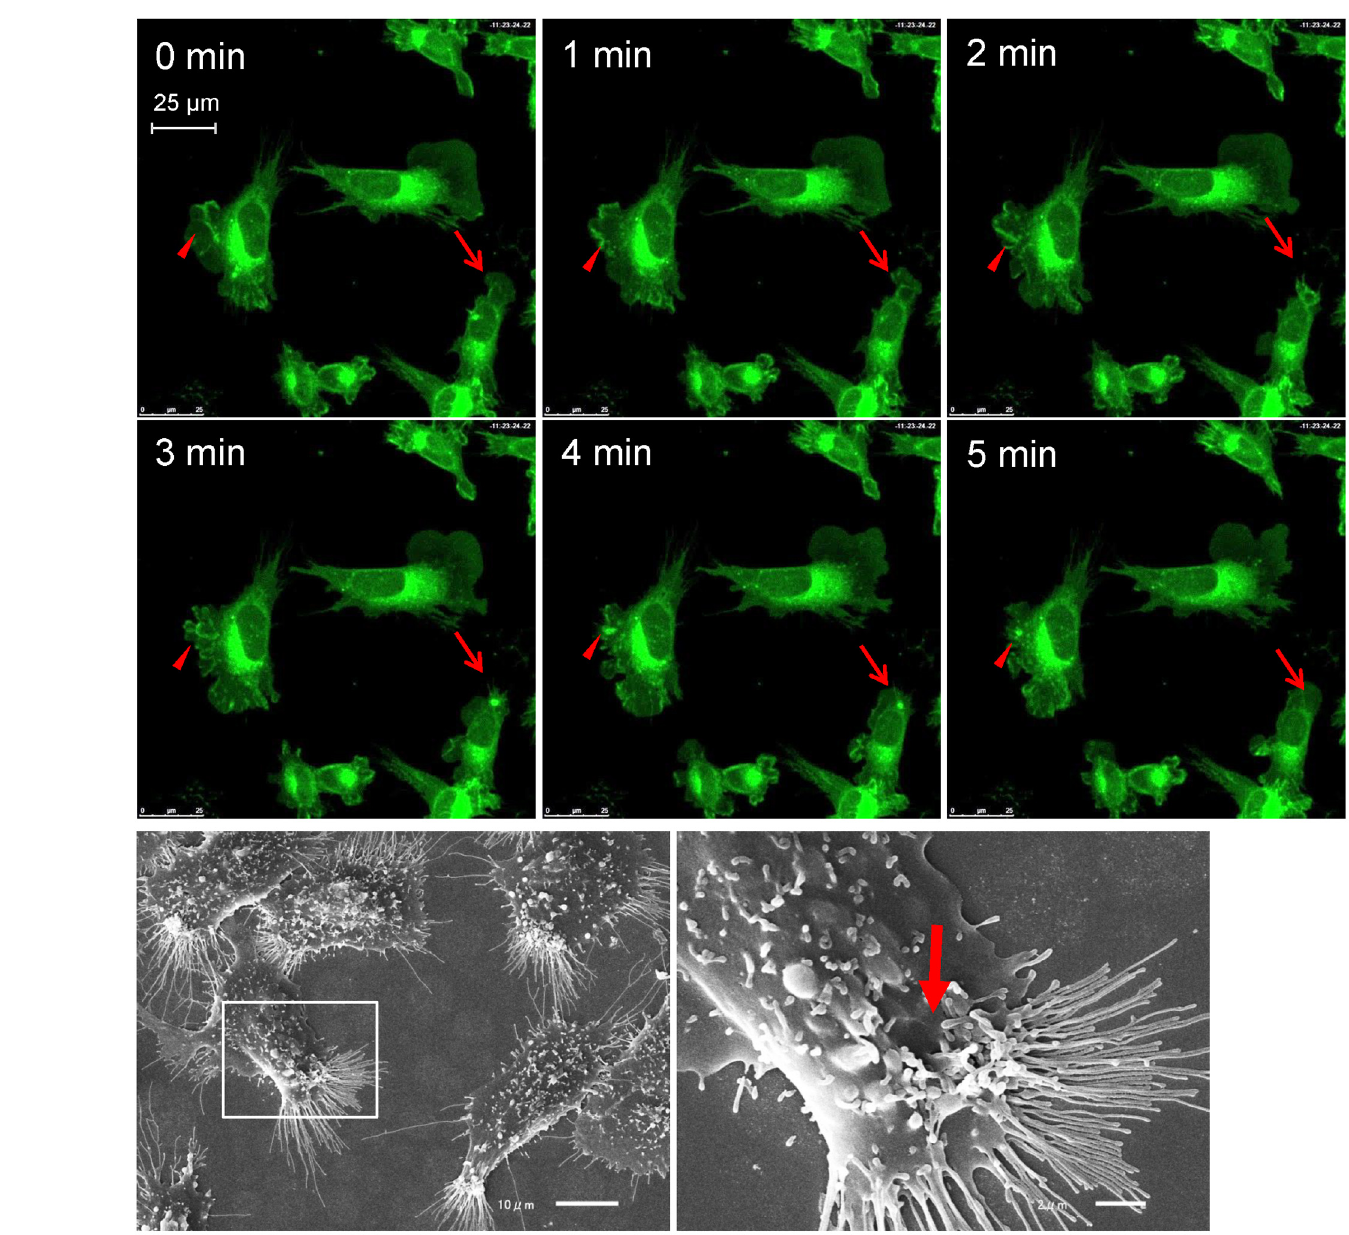
Fig 1. Macropinocytic activity of MARCO-GFP CHO cells. (A) The cells were grown in glass-bottom culture dishes in F12 complete medium and observed using confocal microscopy. Fluorescence images were recorded at 1-min intervals. The arrows and arrowheads indicate the formation and fate of two separate macropinocytic sites. See also S1 Movie. (B) Scanning electron micrographs of GFP-MARCO-CHO cells. The right panel provides a higher magnification image of the boxed area indicated in the left panel. The arrow indicates the macropinocytic